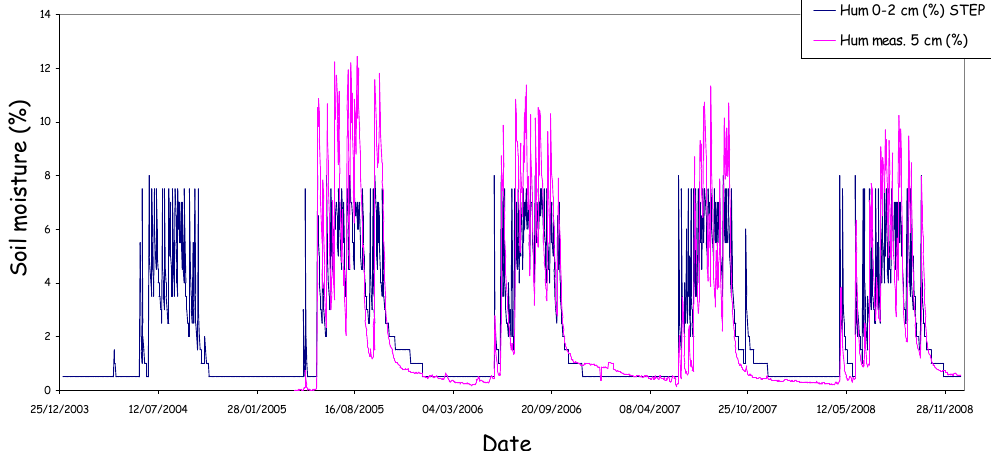
Figure 2. Soil moisture calculated by STEP at the surface layer (0–2cm) in blue, mean soil moisture measured at 5cm in pink, for years 2004 to 2008 at Agoufou.